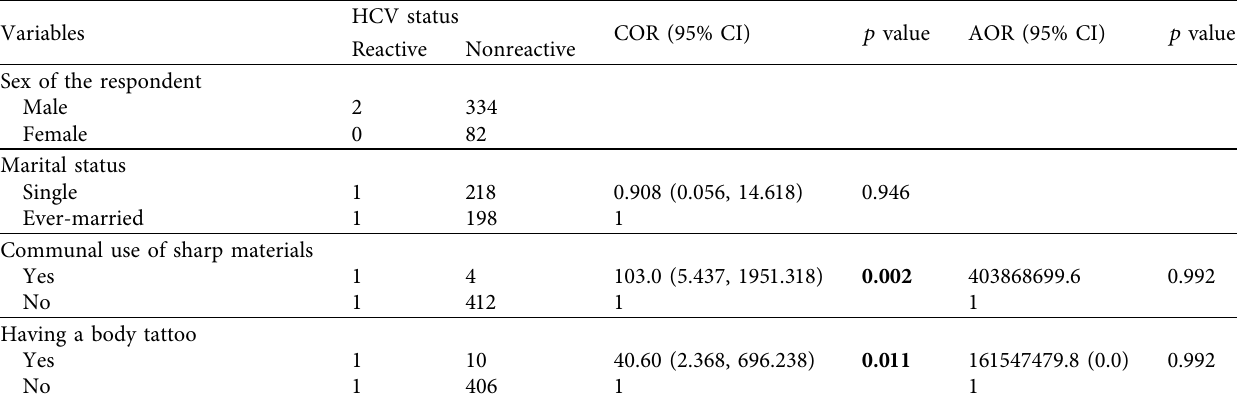
Table 7: Bivariate and multivariate analysis for factors associated with HCV among blood donors at Bahir Dar Blood Bank centre, Northwest Ethiopia, 2020 ( n �